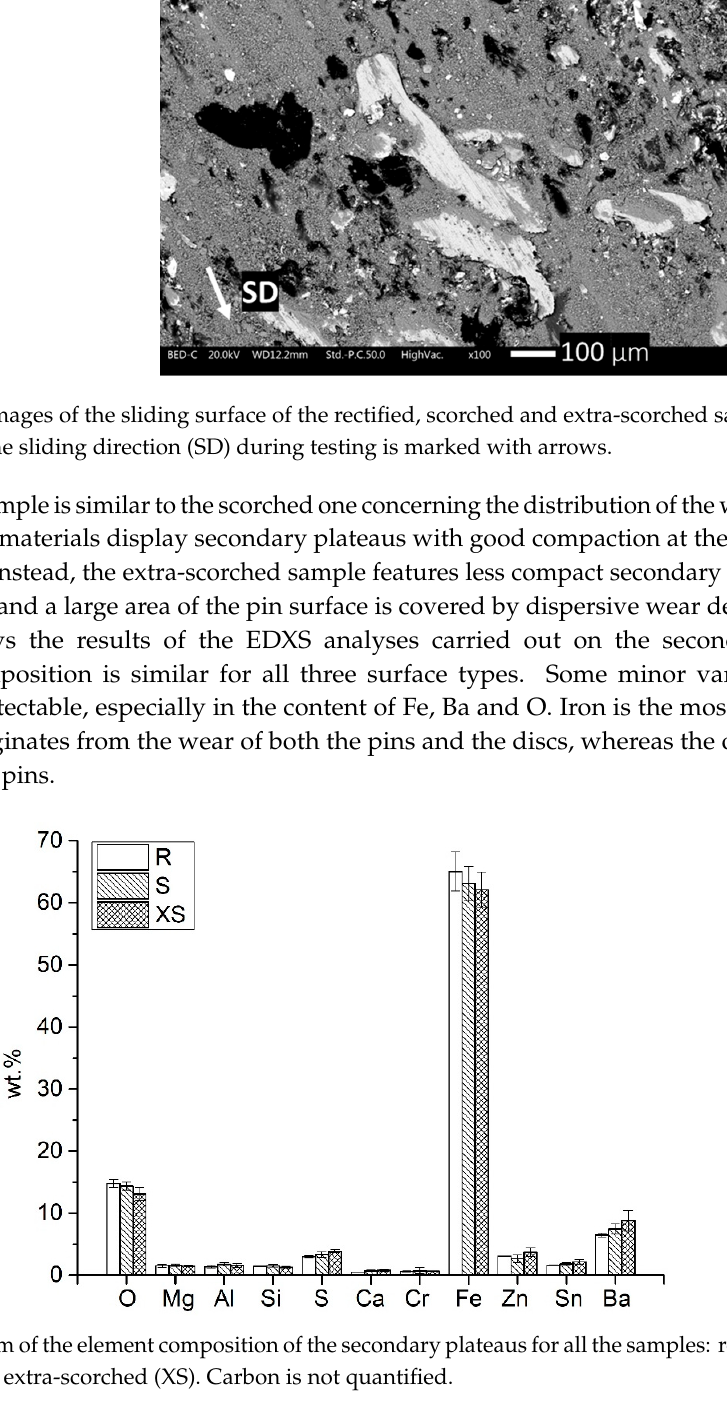
Table 5. Mean and standard deviation of the total measured particle concentration (c ELPI+ and c CPC ), mass of the PM collected on the filters and the mass loss of the pads ( Δ m pad ). Rectified Scorched Extra-Scorched